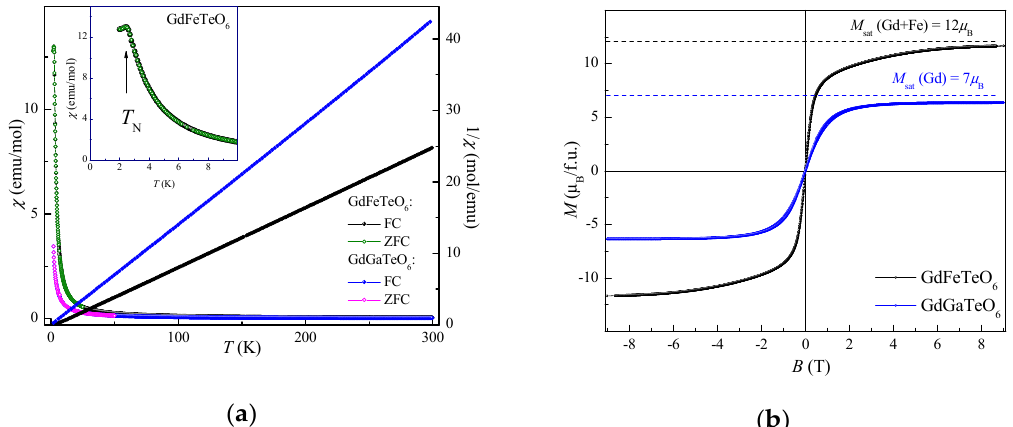
Figure 3. ( a ) The temperature dependences of magnetic susceptibility χ in GdFeTeO 6 and GdGaTeO 6 at B = 0.1 T (left ordinate) and inverse susceptibility 1/ χ (right ordinate). The inset enlarges the low temperature part of χ ( T ) curve for GdFeTeO 6 . ( b ) The field dependences of magnetization M ( B ) in GdFeTeO 6 and GdGaTeO 6 at 2 K.